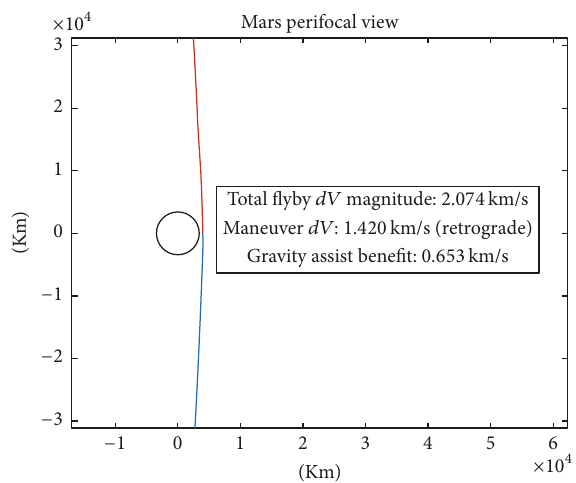
Figure 5: Illustration of the periapse patching of the planet-centric inbound and outbound hyperbolic orbits. Inbound is the blue (bottom) and outbound is the red (top).